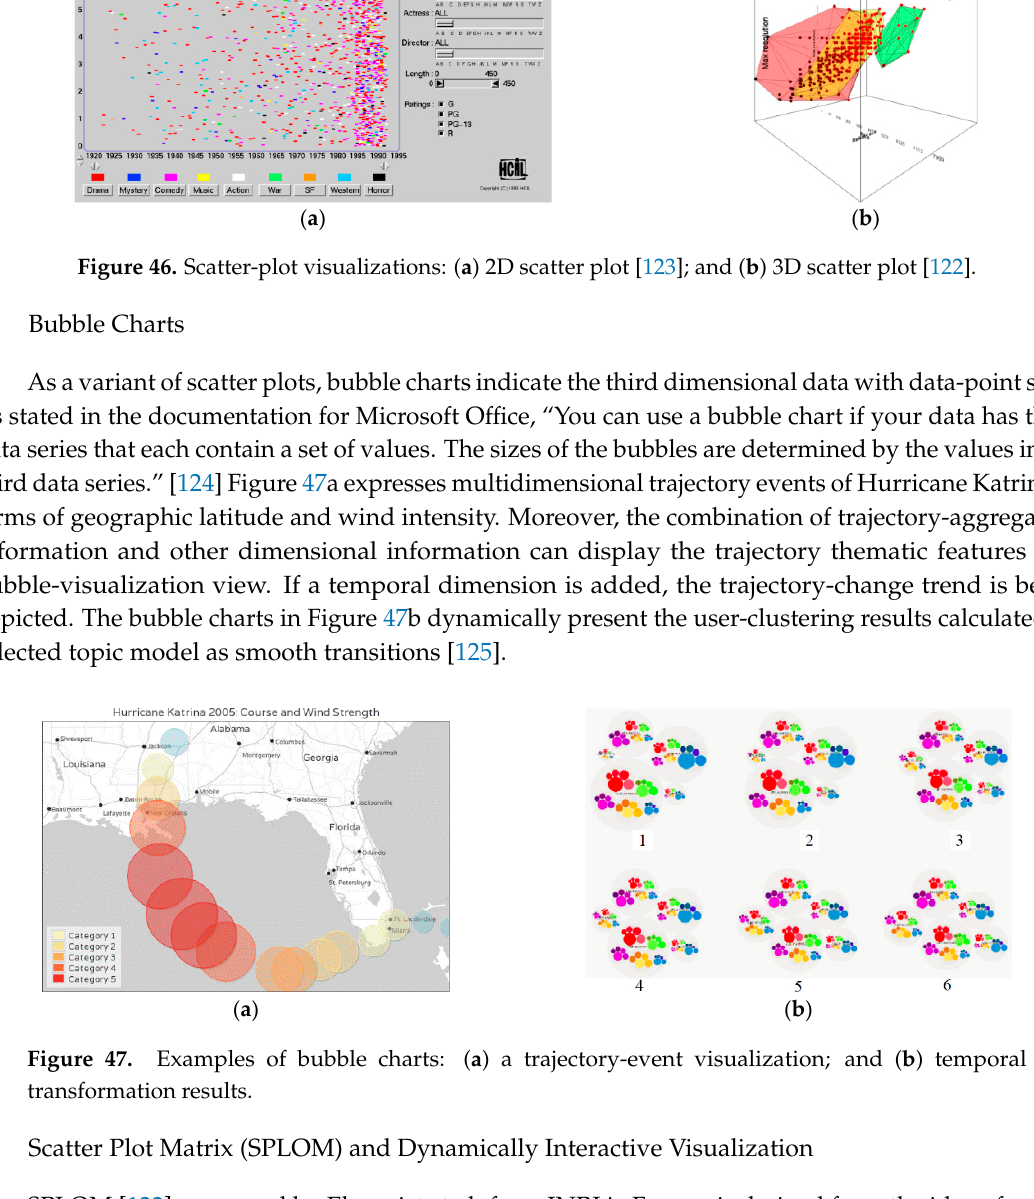
( b ) Figure 48. SPLOM visualization examples: ( a ) exploration of a seven-dimensional car dataset [126]; and ( b ) system interface of the flicker-based animated SPLOM [127]. 5.3. Flow and Stream The analysis and mapping of geographic mobility data is rather essential for comprehending the spatiotemporal dynamics of datasets. Unfortunately, visualizing large mobility data and grasping the complex patterns embedded therein are still challenging research issues because of limited map space and numerous connections. This section divides origin–destination streaming data into spatial view- based flow visualization and non-spatial view-based flow visualization. The main distinction is whether the nodes or locations are fixed in the view because locations are meaningful and critical for interpreting patterns. 1. Spatial View-Based Flow Visualization A flow map is an abstract timeline that is usually applied to depict changes in event subjects between locations, such as population migrations, import and export trades, etc. Tobler [128] studied a flow map at a very early stage and plotted a US population-migration map. Figure 49a shows that the edges in his flow map suffers from severe overlapping. Doantam et al. [129] proposed an edge-